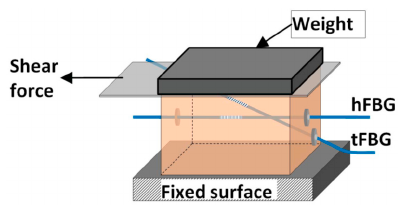
Figure 6. Diagram of normal and shear stress sensor using PFBGs [122].